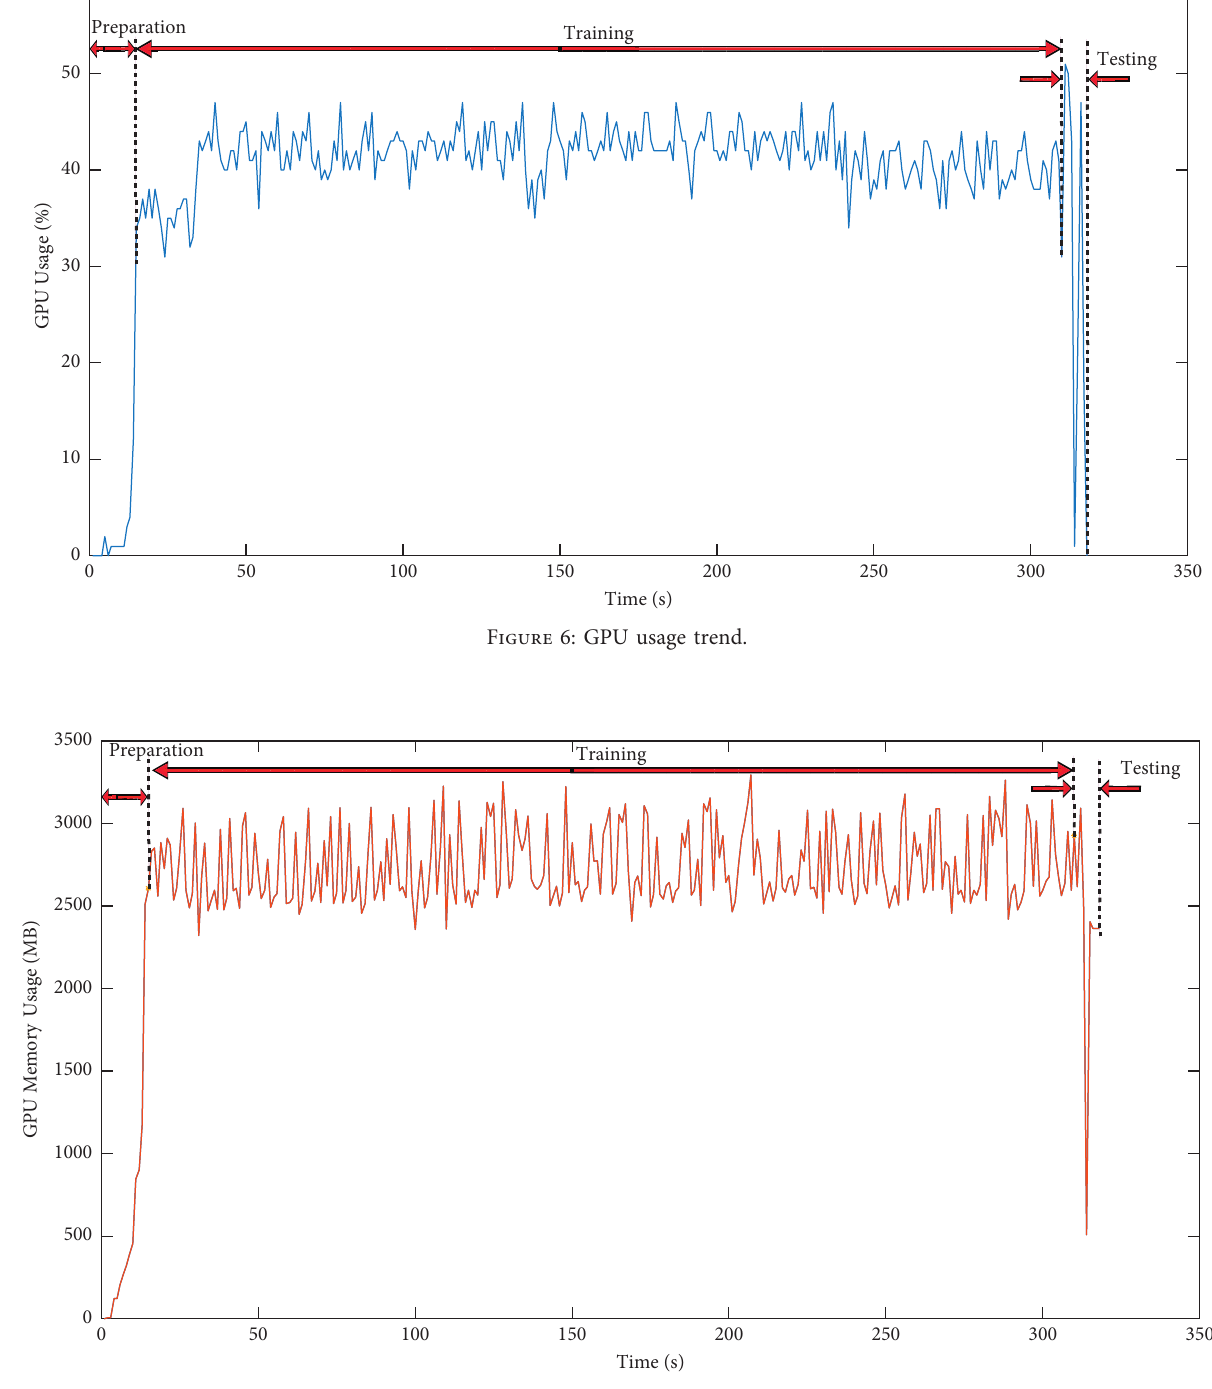
Figure 7: GPU memory usage